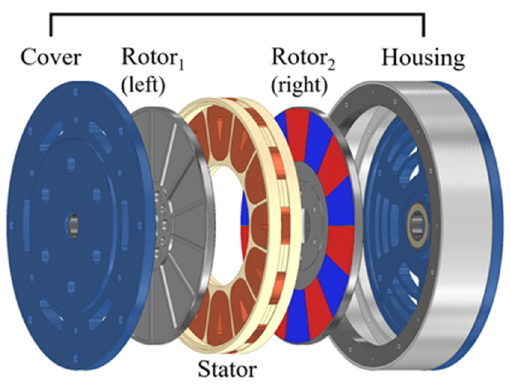
Figure 1. DR-SS generator configuration example.